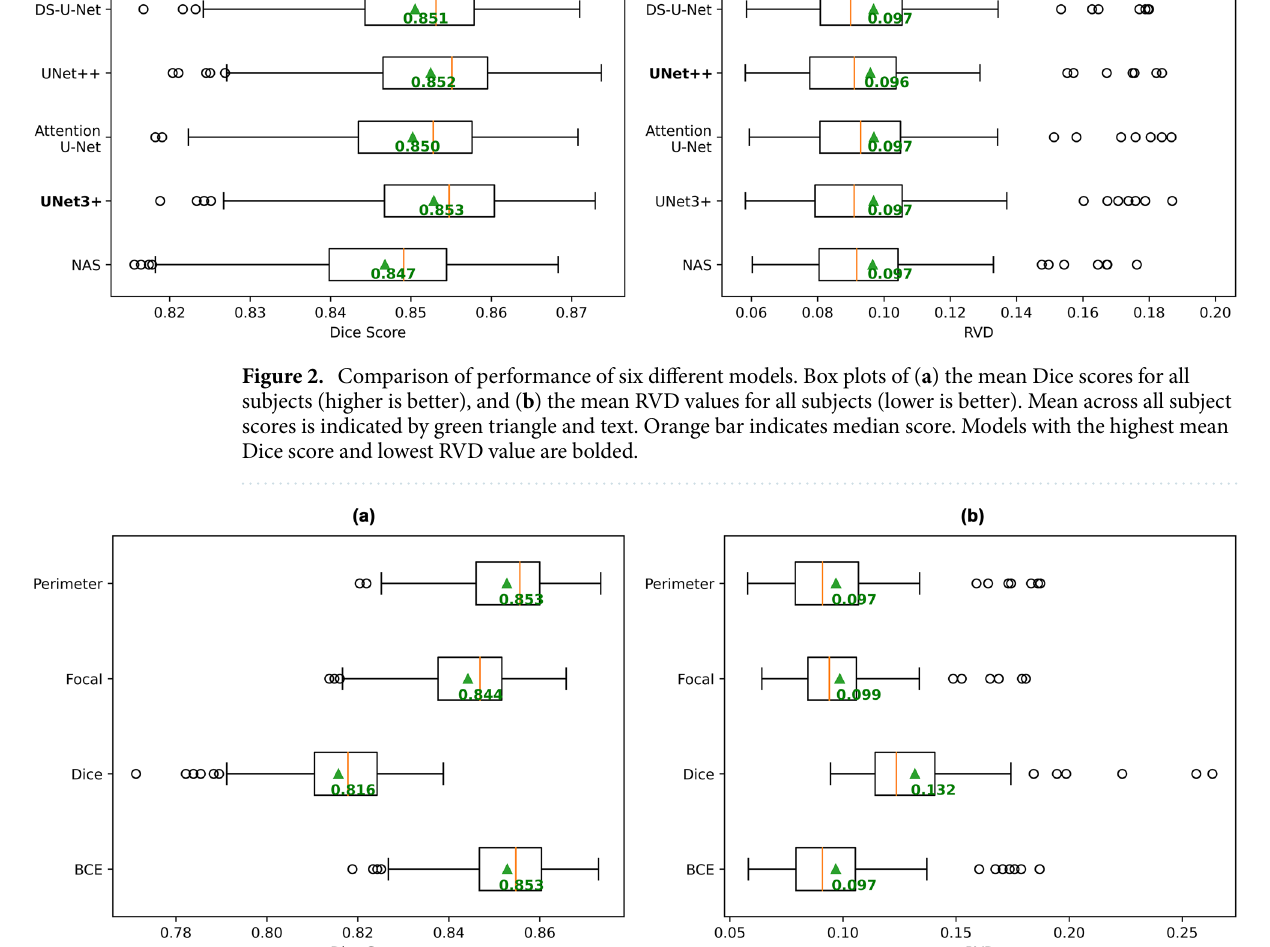
Figure 3. Comparison of performance of UNet3+ trained with different loss functions. Box plots of ( a ) the mean Dice scores for all subjects (higher is better), and ( b ) the mean RVD values for all subjects (lower is better). Mean across all subject scores is indicated by green triangle and text. Orange bar indicates median